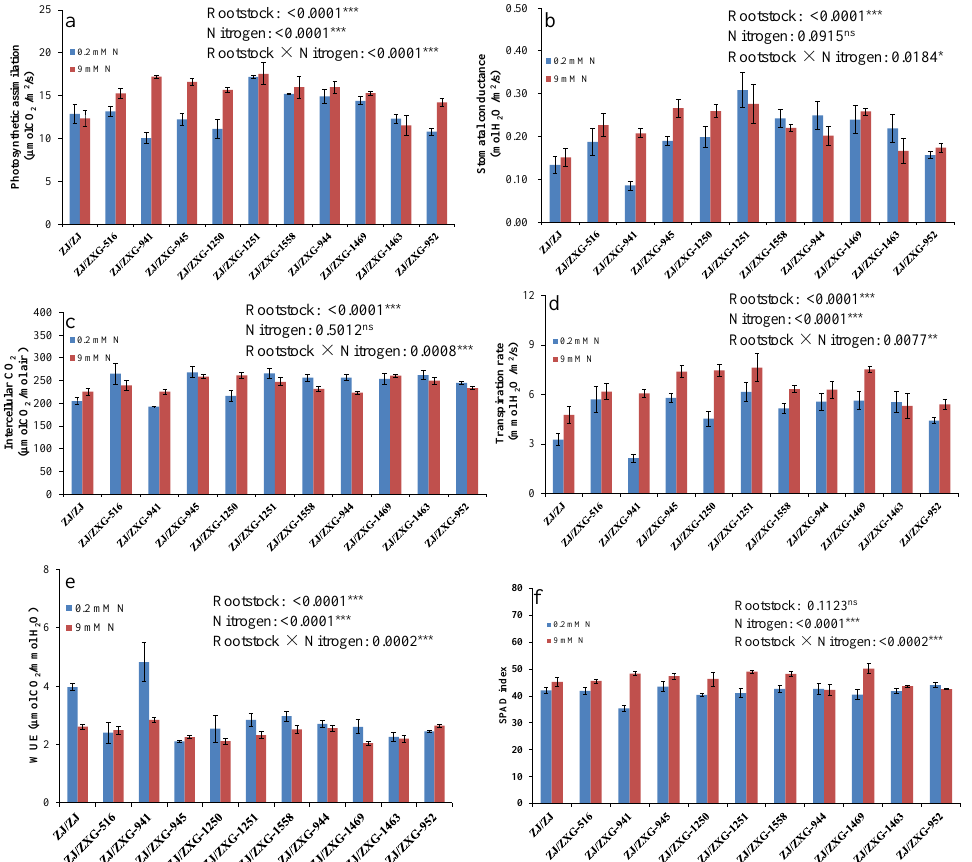
Figure 2. Photosynthetic assimilation ( a ), stomatal conductance ( b ), intercellular CO 2 ( c ), transpiration rate ( d ), water use efficiency ( e ), and SPAD index (relative chlorophyll content) ( f ) of watermelon cultivar Zaojia 8424 (ZJ), self-grafted (ZJ/ZJ) and grafted onto 10 different wild watermelon rootstocks under normal (9 mM) and low (0.2 mM) N conditions. Values are means ± SE of three replicates. *, **, and *** represent P ≤ 0.05, 0.01 and 0.001, respectively, and ns means not significant.